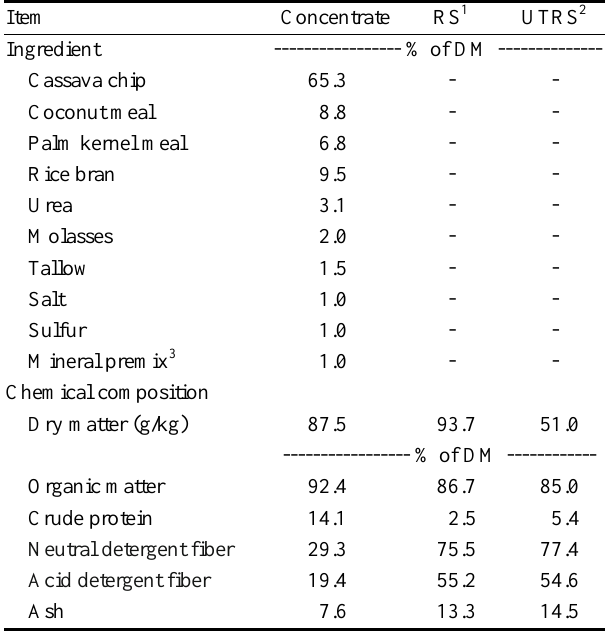
Table 1. Ingredients and chemical composition of concentrate, untreated rice straw and urea-treated (3%) rice straw